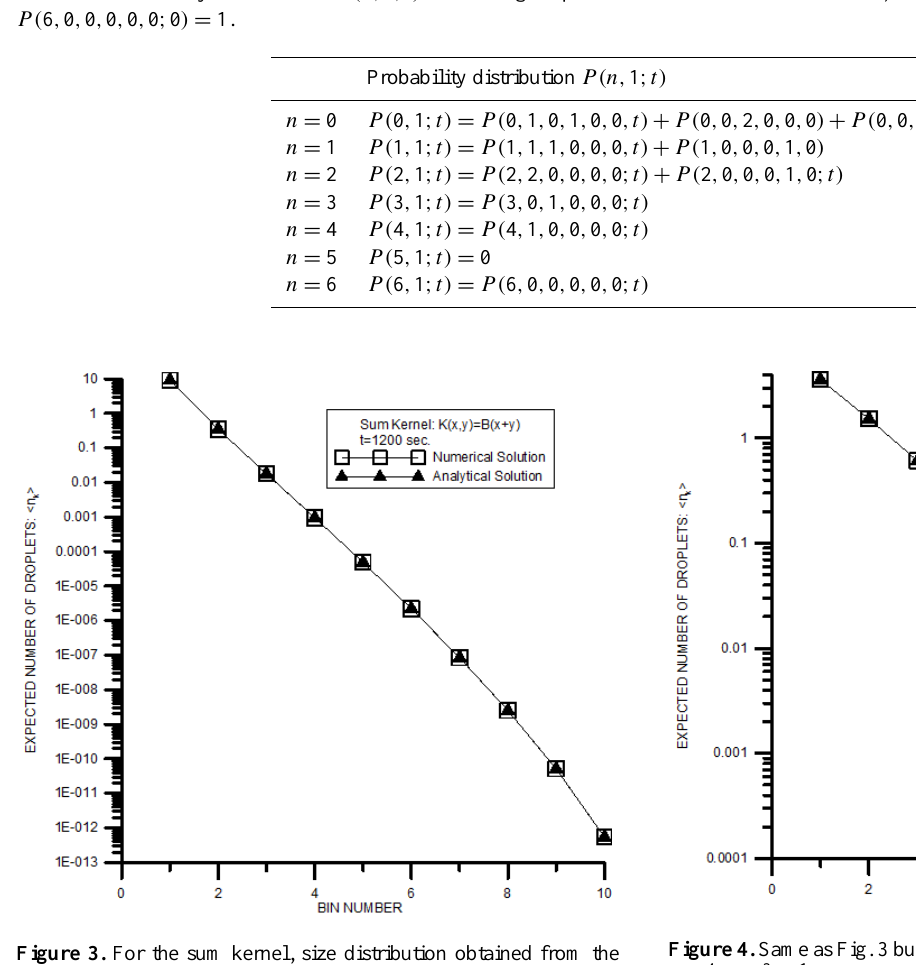
step was set equal to (cid:49)t = 0 . 1 s. Comparisons between the